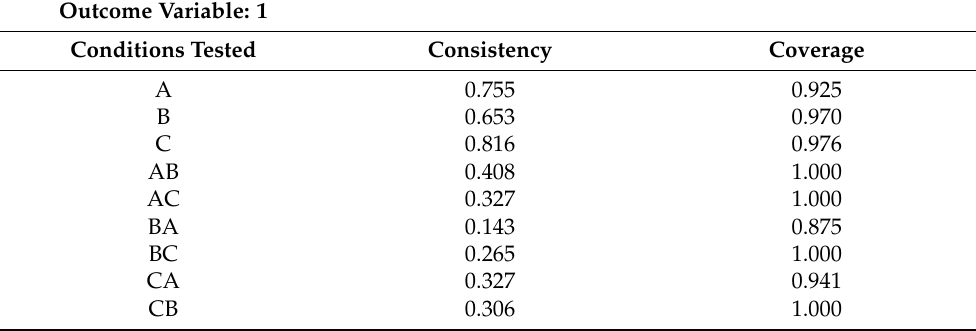
Table 5. Results of Necessity Tests (Hazard #2). Outcome Variable: 1